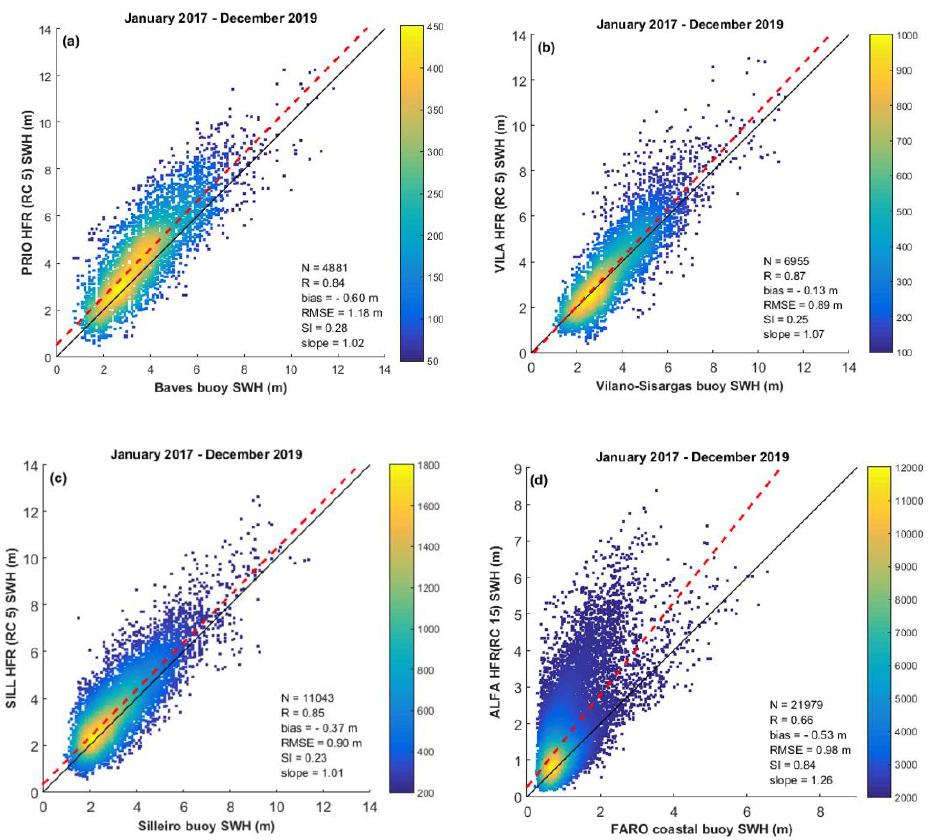
Figure 7. Comparisons between buoy and HFR SWH (density scatter plots). Statistics metrics are gathered on the right bottom side. N represents the number of coincident hourly observations, and the red dashed lines are the best linear fit of the scatter plots. Density scatter plot: ( a ) Baves buoy vs. PRIO HFR (RC5); ( b ) Villano-Sisargas buoy vs. VILA HFR (RC5); ( c ) Silleiro buoy vs. SILL HFR (RC5) and ( d ) Faro coastal buoy vs. ALFA HFR (RC15). The colored bar represents the density of the scatter plots.